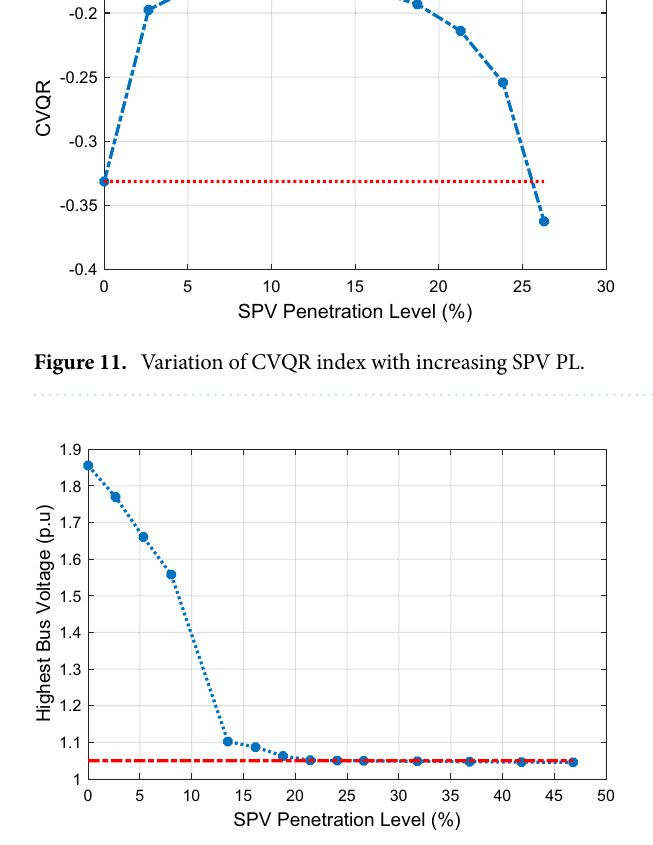
Figure 12. Impact of increasing SPV penetration on highest bus voltage with SPV located at selected Northern buses.